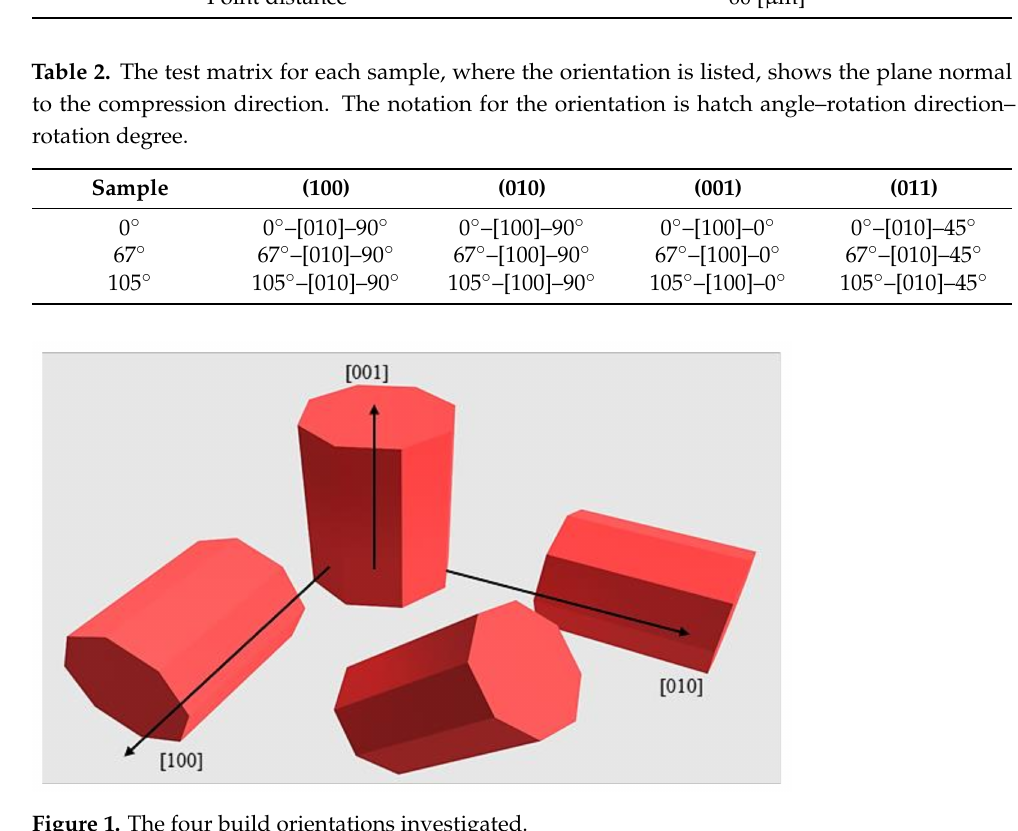
Figure 1. The four build orientations investigated. Compression testing was done as described in ASTM E3 using self-aligning platens. The samples were loaded at a strain rate of 5 × 10 − 3 per min. The cylinders were com- pressed to well past the yield point. After compression testing, only two values, the yield strength and aspect ratio, were estimated and used for the anisotropy investigation. The yield strength was estimated at 0.2% offset, while the aspect ratio was estimated from the final specimen geometry. A macro lens camera was used to take close-up images of the top and sides of each specimen, where the top surface images were converted to binary (the top surface was black and the background white). FIJI software was used to estimate the aspect ratio of the specimens using the Feret diameters. After the Feret measurements, the samples were prepared for metallography. They were mounted in bakelite and polished to 0.05 microns in colloidal silica. The samples were electrolytically etched in a 60:40 nitric acid for optical microscopy (water solution at 6 volts for approximately 5 s). Vicker’s hard- ness measurements were again taken along the top surface of a tested specimen to map the hardness across the deformed specimen to track the local magnitude of plastic